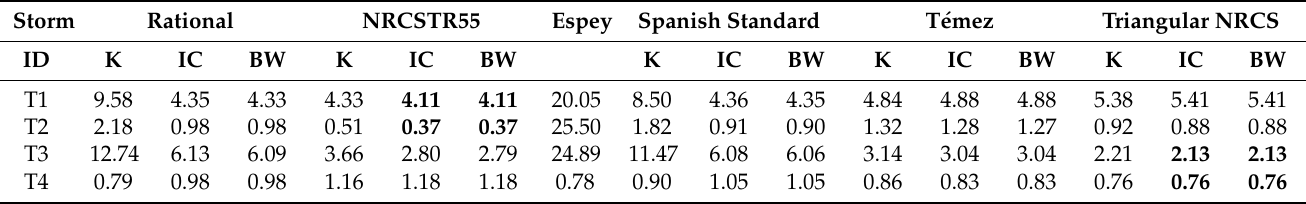
Table 4. Resulting RMSE values in the four storms studied. The results with the lowest RMSE are in bold. Storm Rational NRCSTR55 Espey Spanish Standard T é mez Triangular